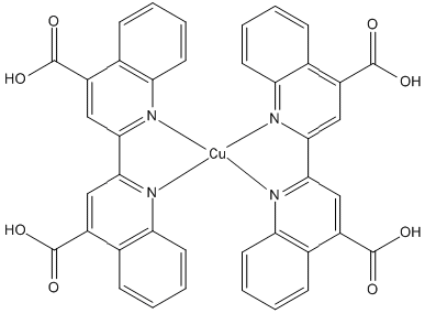
Figure 8. Copper structure.